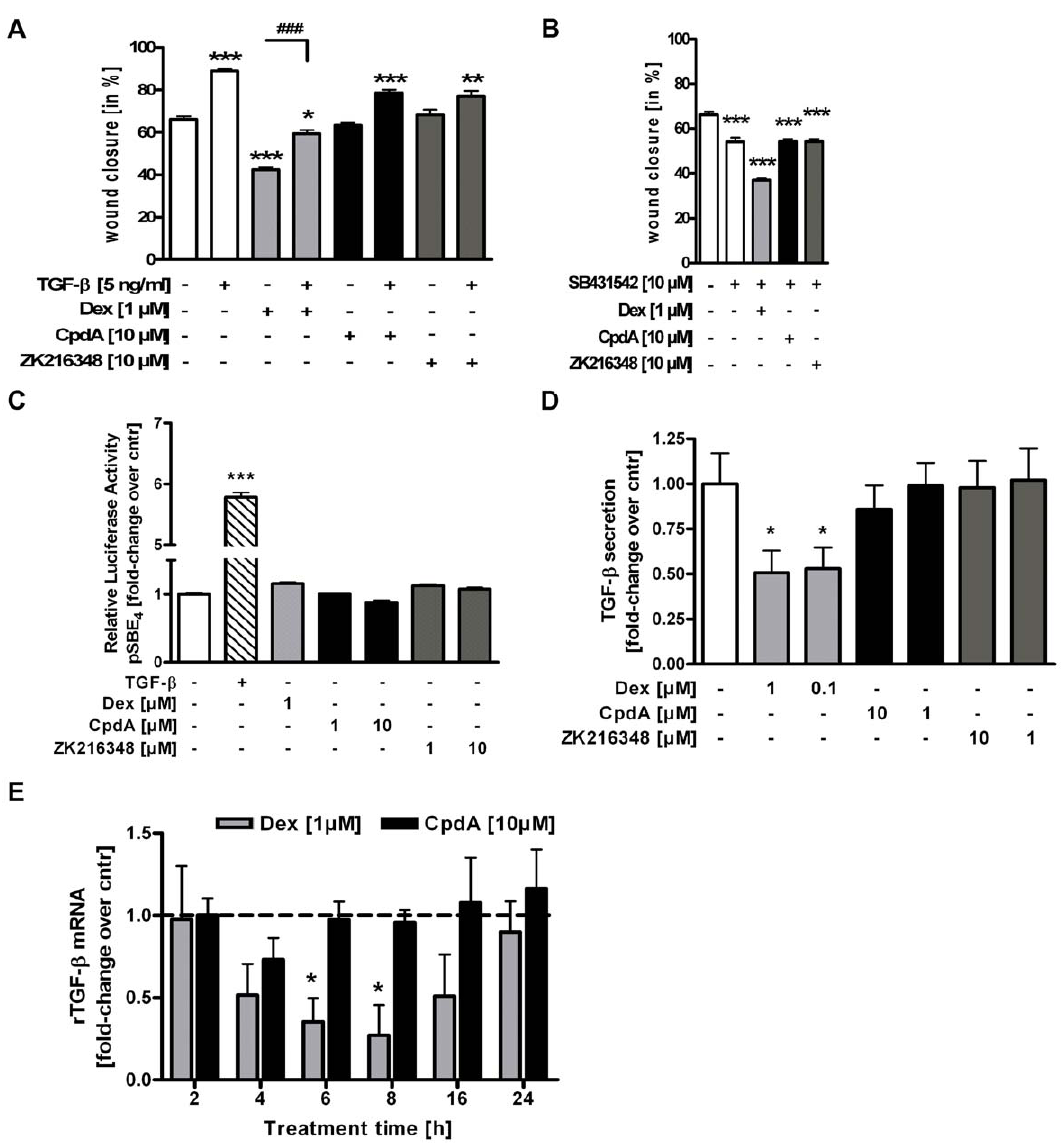
Figure 5. Effect of SEGRAs on TGF- b - mediated intestinal epithelial cell restitution. Wounded IEC-6 cells were cultured for 24 h in the presence of Dex, CpdA or ZK216348 with or without co-presence of ( A ) TGF- b or ( B ) selective inhibitor of activin receptor-like kinase (ALK) receptor SB431542. Cell migration was assessed using an in vitro migration assay. Bars indicate mean values of remaining wounded area 6 S.E.M., n=3, * P # 0.05, ** P # 0.01, *** P # 0.001 relative to vehicle, ### P # 0.001 relative to Dex ( C ) Relative luciferase activity of HEK293T cells transfected with the reporter gene construct pSBE4-luc construct after 24 h incubation with TGF- b (5 ng/ml), Dex or SEGRAs. IEC-6 cells were treated with Dex, CpdA or ZK216348 for the indicated time periods. ( D ) TGF- b peptide levels in cell culture supernatants were determined by ELISA. ( E ) TGF- b mRNA expression was monitored by qPCR and normalised against b -actin. Bars represent mean 6 S.E.M., n=3, * P # 0.05 relative to vehicle.